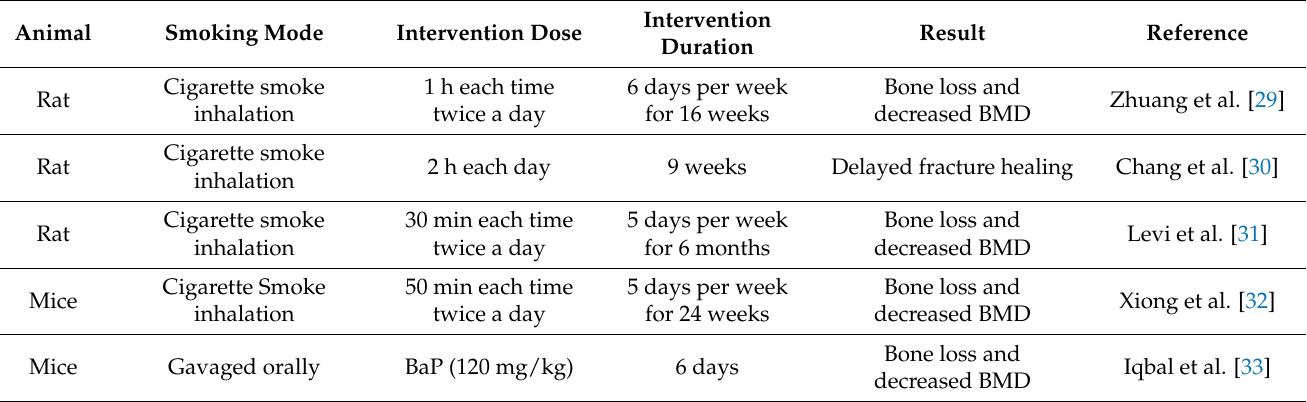
Table 2. Animal models of cigarette smoking-induced